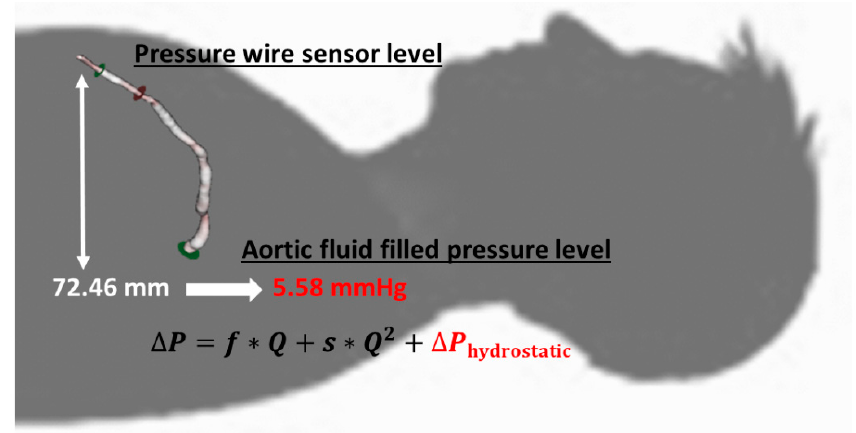
Figure 3. The height difference between the LAD orifice and the sensor position. After 3D reconstruction, the height difference between the orifice and the pressure wire sensor was transformed to mmHg getting hydrostatic pressure (red) (Case 10). This value (5.58 mmHg) influences the gradient between the aortic pressure at the tip of the catheter and the pressure detected by the sensor of the pressure wire, and it has a great impact on the results of the CFR calculation.